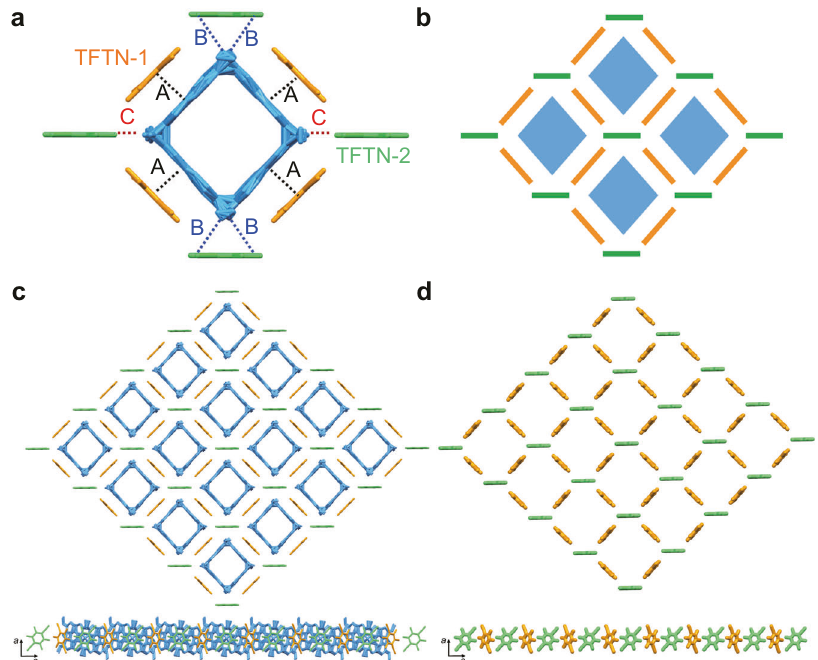
Fig. 8 Supramolecular tessellations of P4 with TFTN in dichloromethane system. Crystal structure of P4-TFTN b showing a perfect rhombic P4 with TFTN molecules surrounding each side and vertex of the rhombus unit; b schematic representation of the rhombic tiling; c two-dimensional regular rhombic tiling formed by P4 and TFTN in a plane; d regular rhombic grids formed by TFTN molecules. Different colors represent the symmetry equivalence and hydrogen atoms are omitted for clarity. Crystallographically independent TFTN molecules were marked as TFTN-1 and